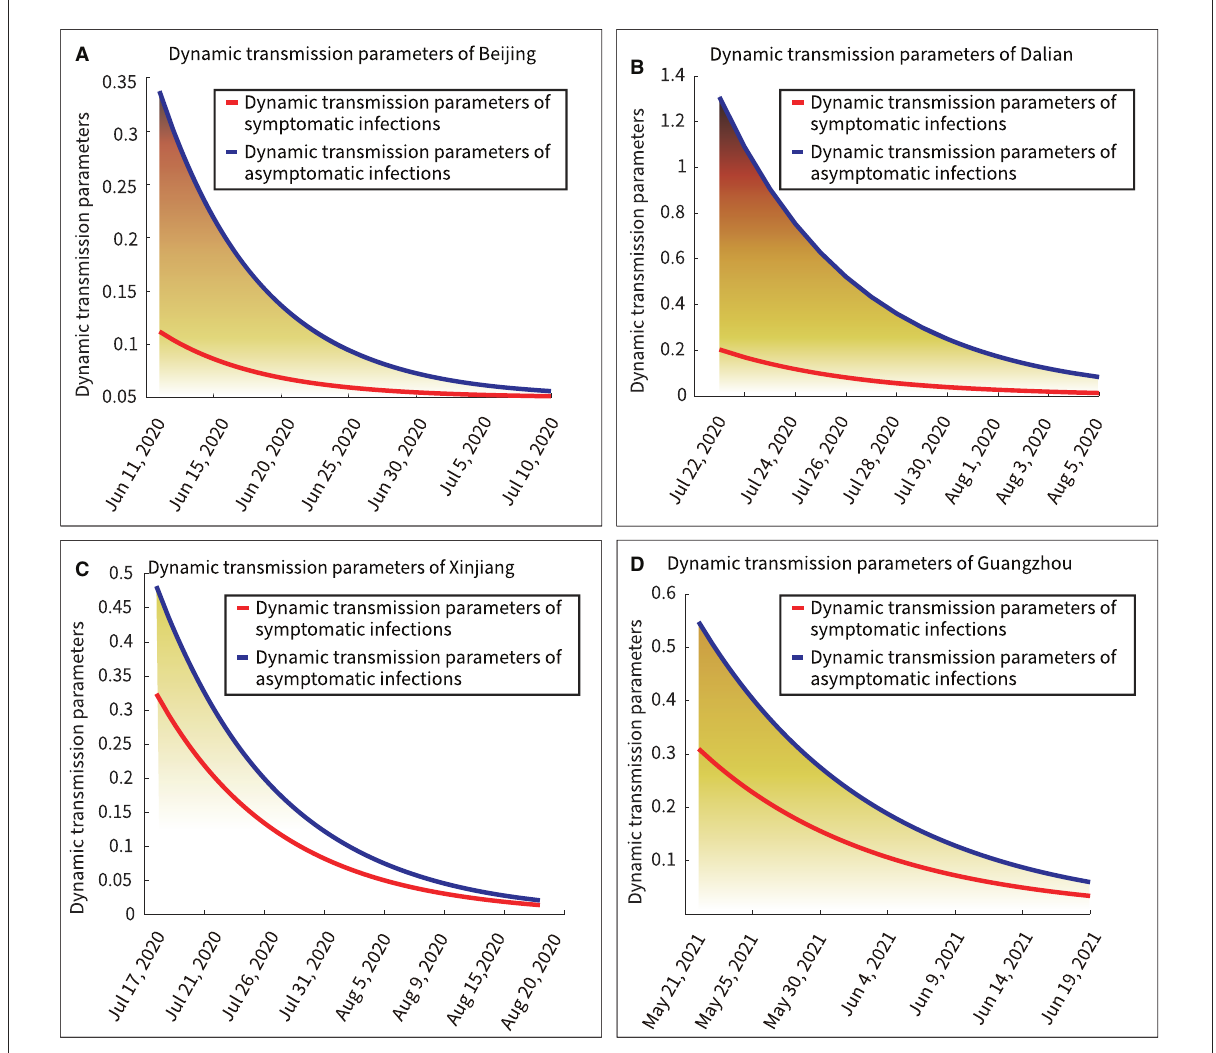
FIGURE7 Dynamic transmission power parameters of symptomatic and asymptomatic infections. (A) Beijing, (B) Dalian, (C) Xinjiang, (D) Guangzhou.